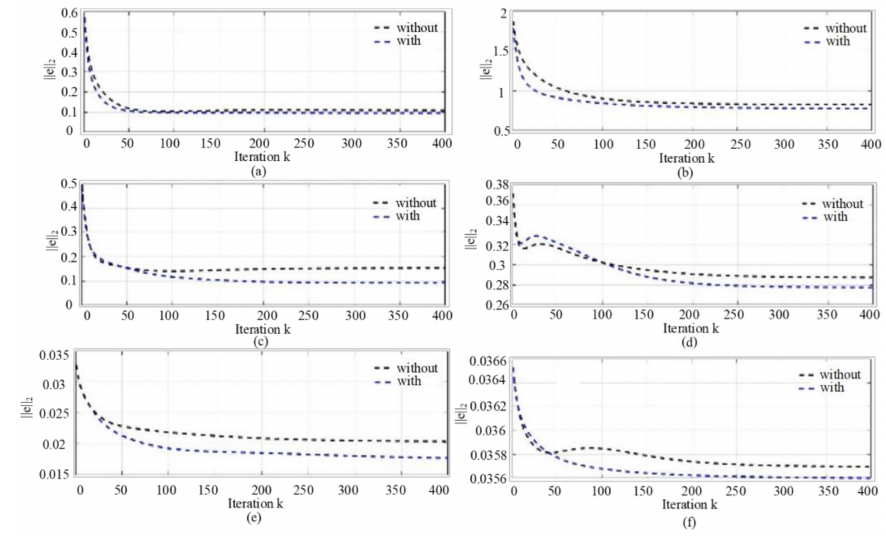
Figure 7. Comparison of acceleration-type ILC without and with past information. (Blue: with, Black: without) ( a ) Joint 1. ( b ) Joint 2. ( c ) Joint 3. ( d ) Joint 4. ( e ) Joint 5. ( f ) Joint 6.